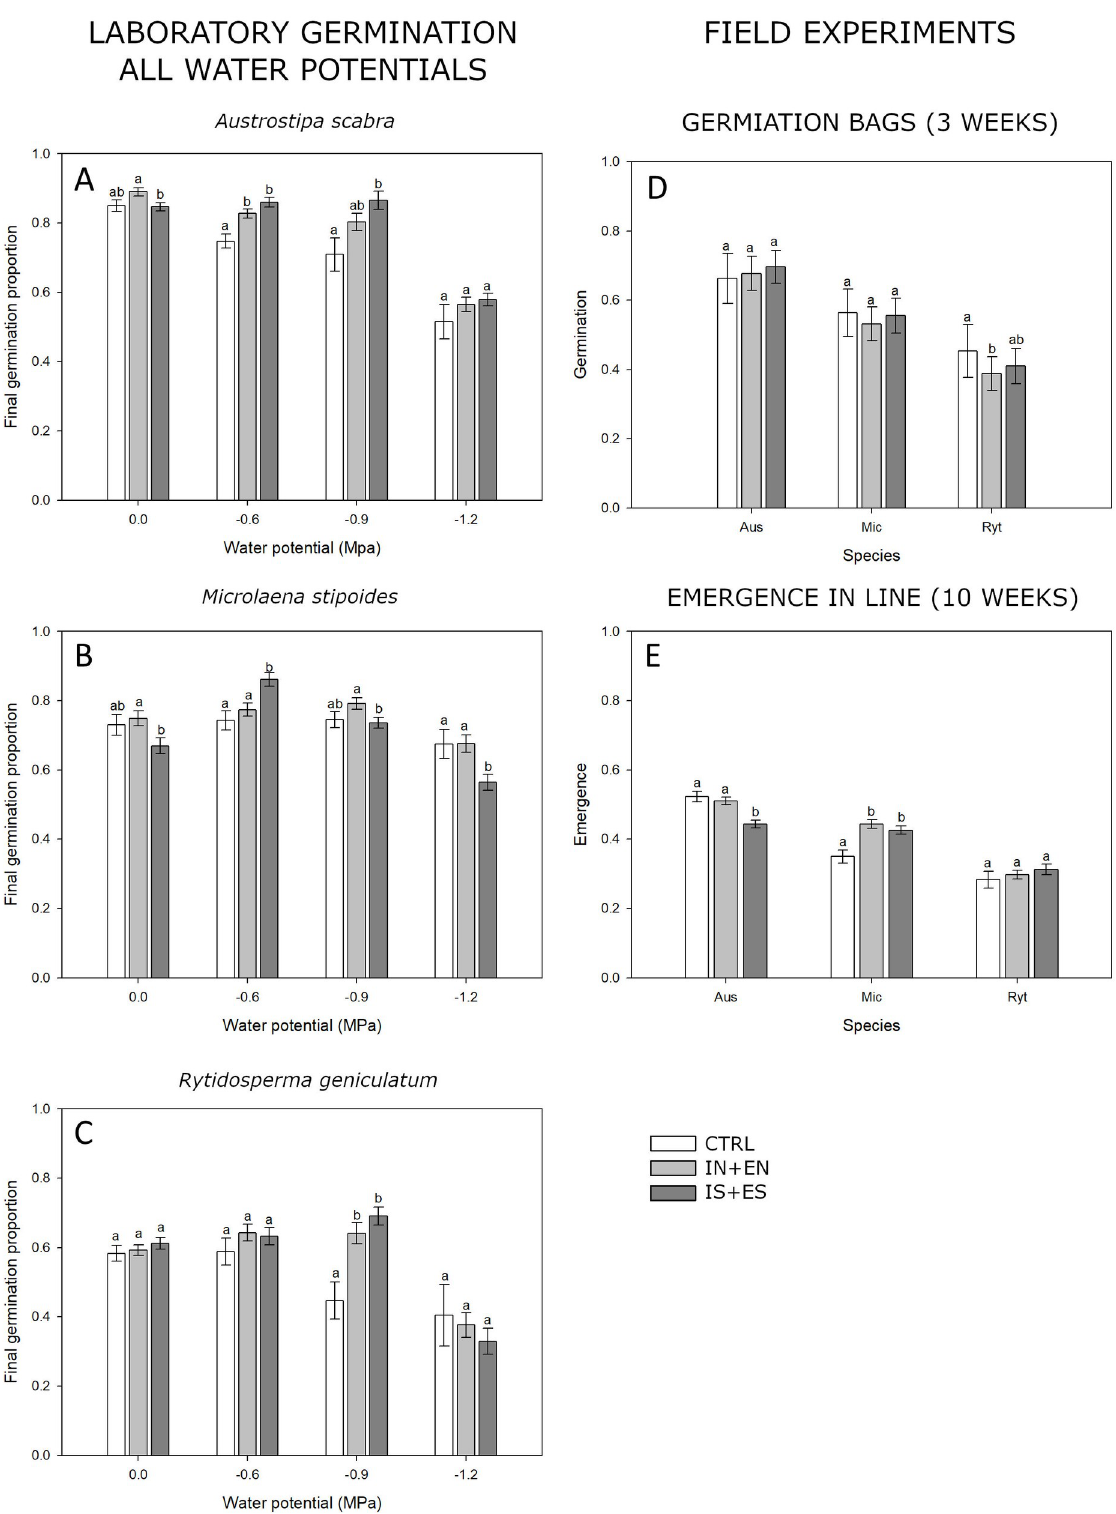
Fig 4. Salicylic acid final germination and emergence. Final germination and emergence of untreated seeds (CTRL), seed treated without salicylic acid (IN+EN) and seed treated with salicylic acid (IS+ES). A, B and C shows the laboratory germination experiment in petri dishes at 20˚C at different water potentials (X axis). D and E show the germination and emergence results in field experiment 3 and 10 weeks after